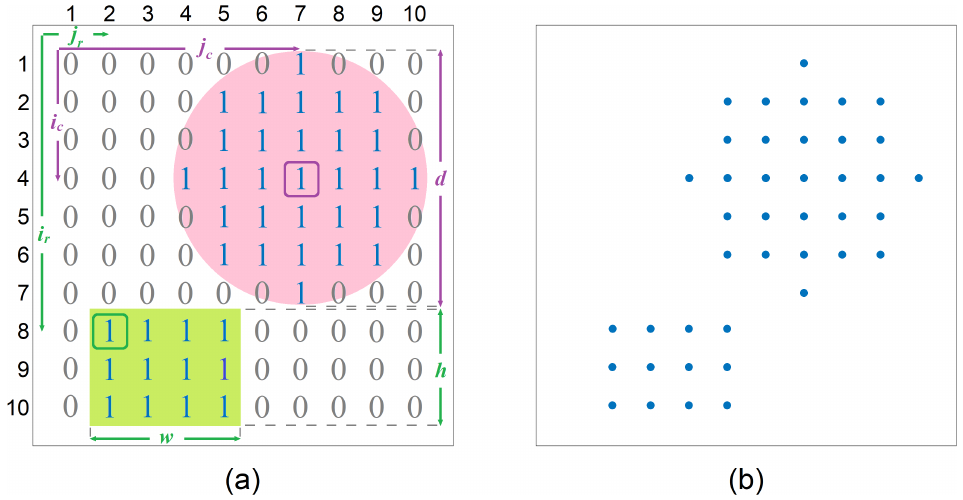
Figure 1. ( a ) Matrix space approximations of a rectangle with h = 3 rows height and w = 4 columns width, and a circle with d = 7 cells diameter. The upper-left corner of the rectangle and center of the circle are located on ( i r = 8, j r = 2) and ( i c = 4, j c = 7), respectively. ( b ) The sparsity pattern of the matrix containing the objects.